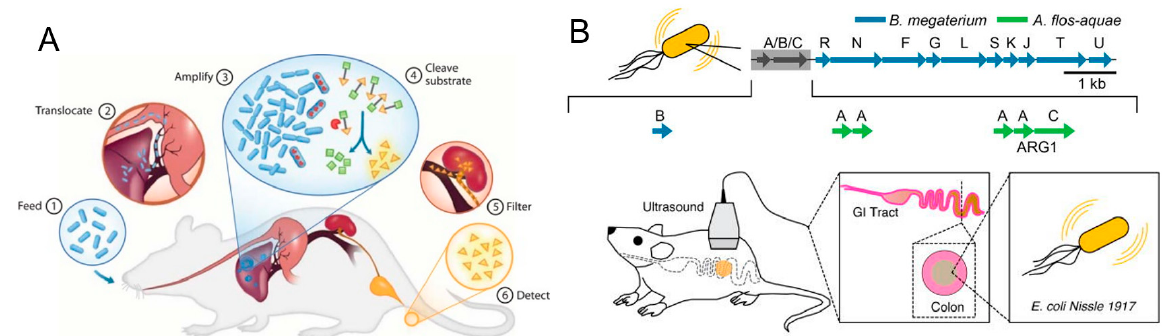
Figure 5. Programmed bacteria for diagnosis and bioimaging. ( A ) Genetically modified probiotics for noninvasive cancer diagnosis. Adapted with permission from [27]; published by BioMed Central, 2015. ( B ) Ultrasound imaging of engineered bacteria-carrying acoustic reporter genes in the gastrointestinal (GI) tract. Adapted with permission from [34]; published by Nature Research, 2018.